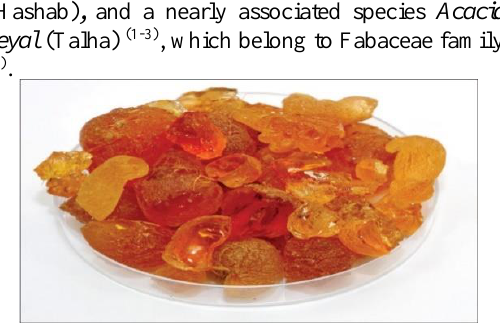
Figure 1. Gum Arabic; raw material